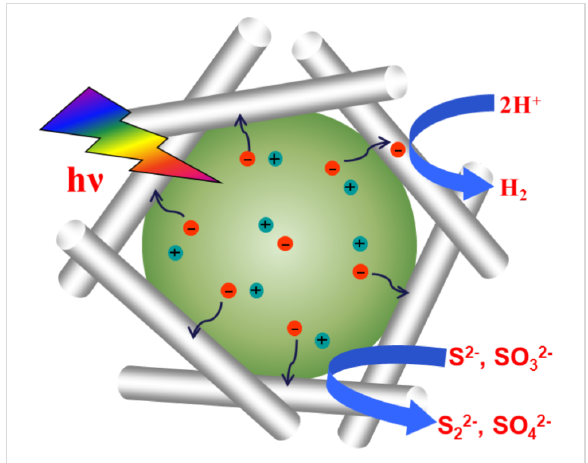
Figure 5: CdS nanoparticle enwrapped by the surrounding TNTs showed a significant enhancement of charge separation and therefore a high activity. Reproduced with permission from [33]. Copyright (2011) The Royal Society of Chemistry.